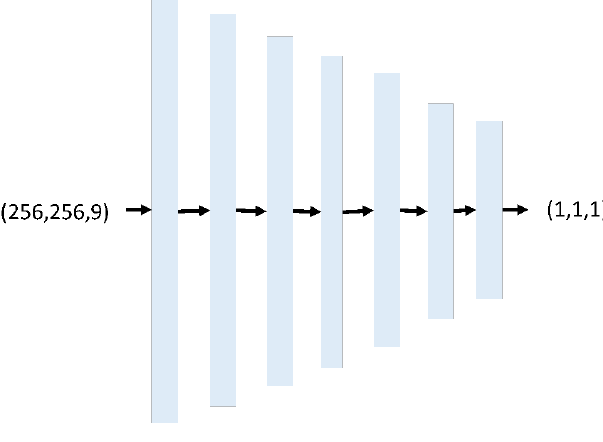
Figure 8. Discriminator